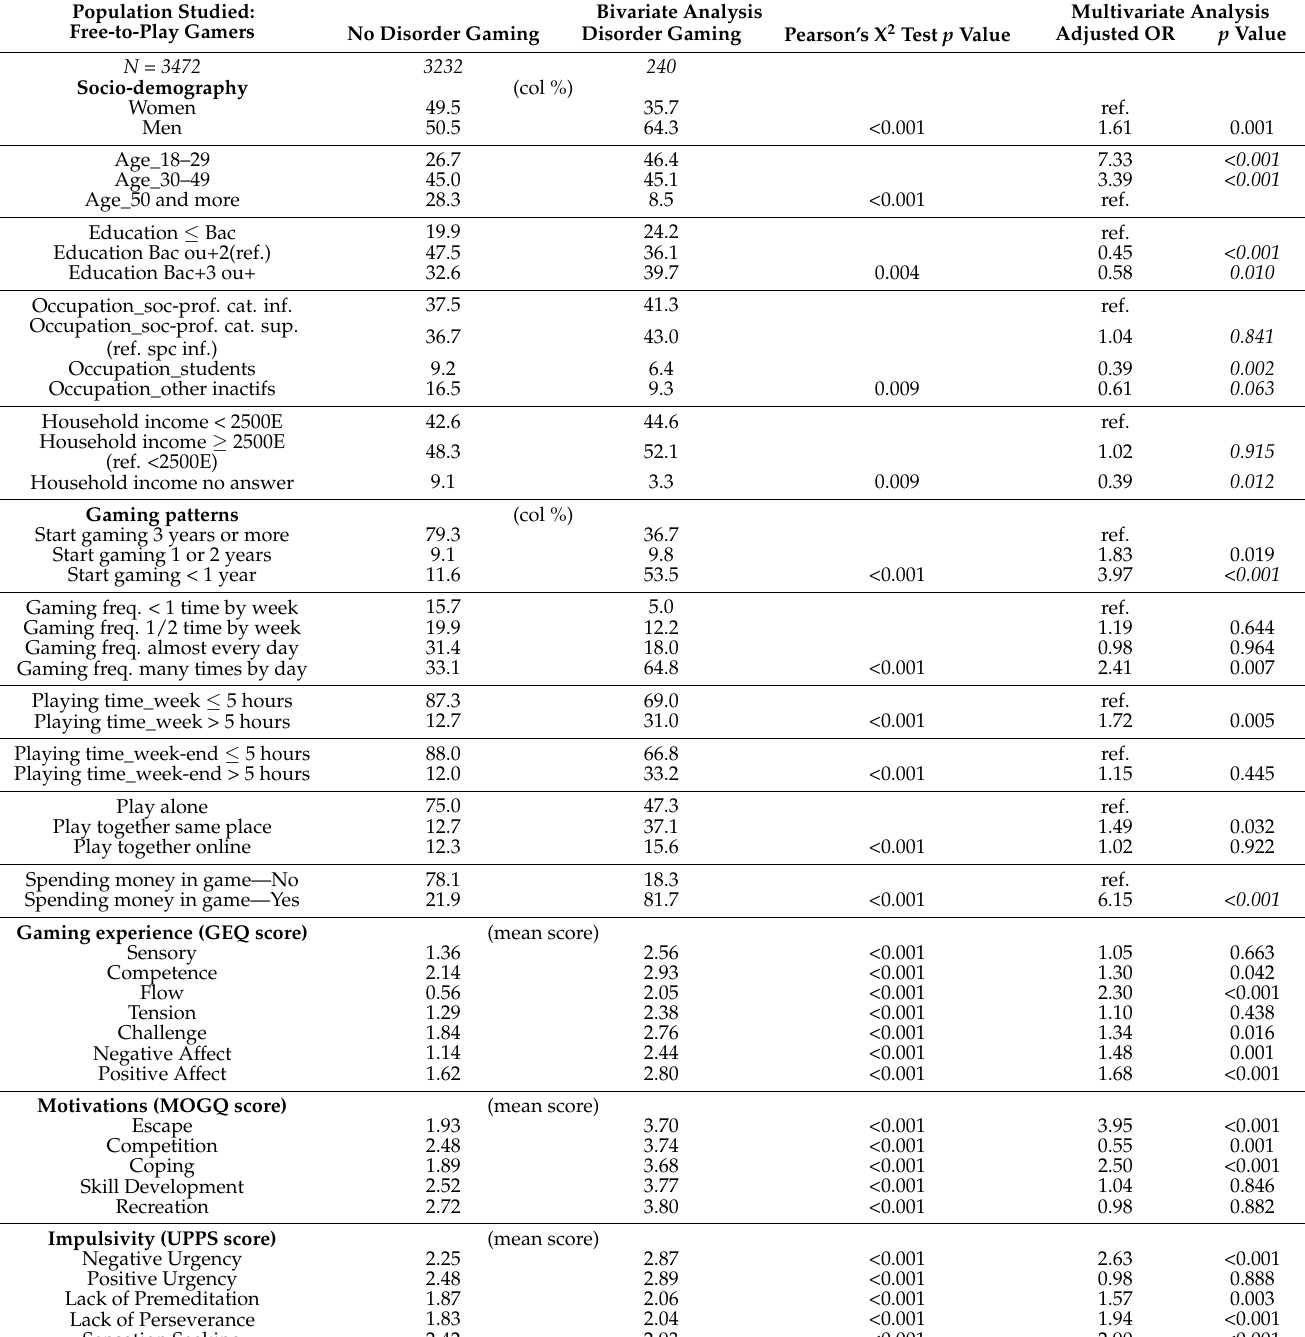
Table 3. Internet gaming disorder—multifactorial predictive